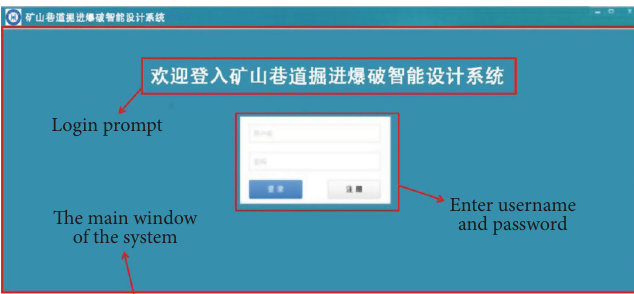
Figure 8: The startup interface of the intelligent design system for mine tunnel blasting based on database.